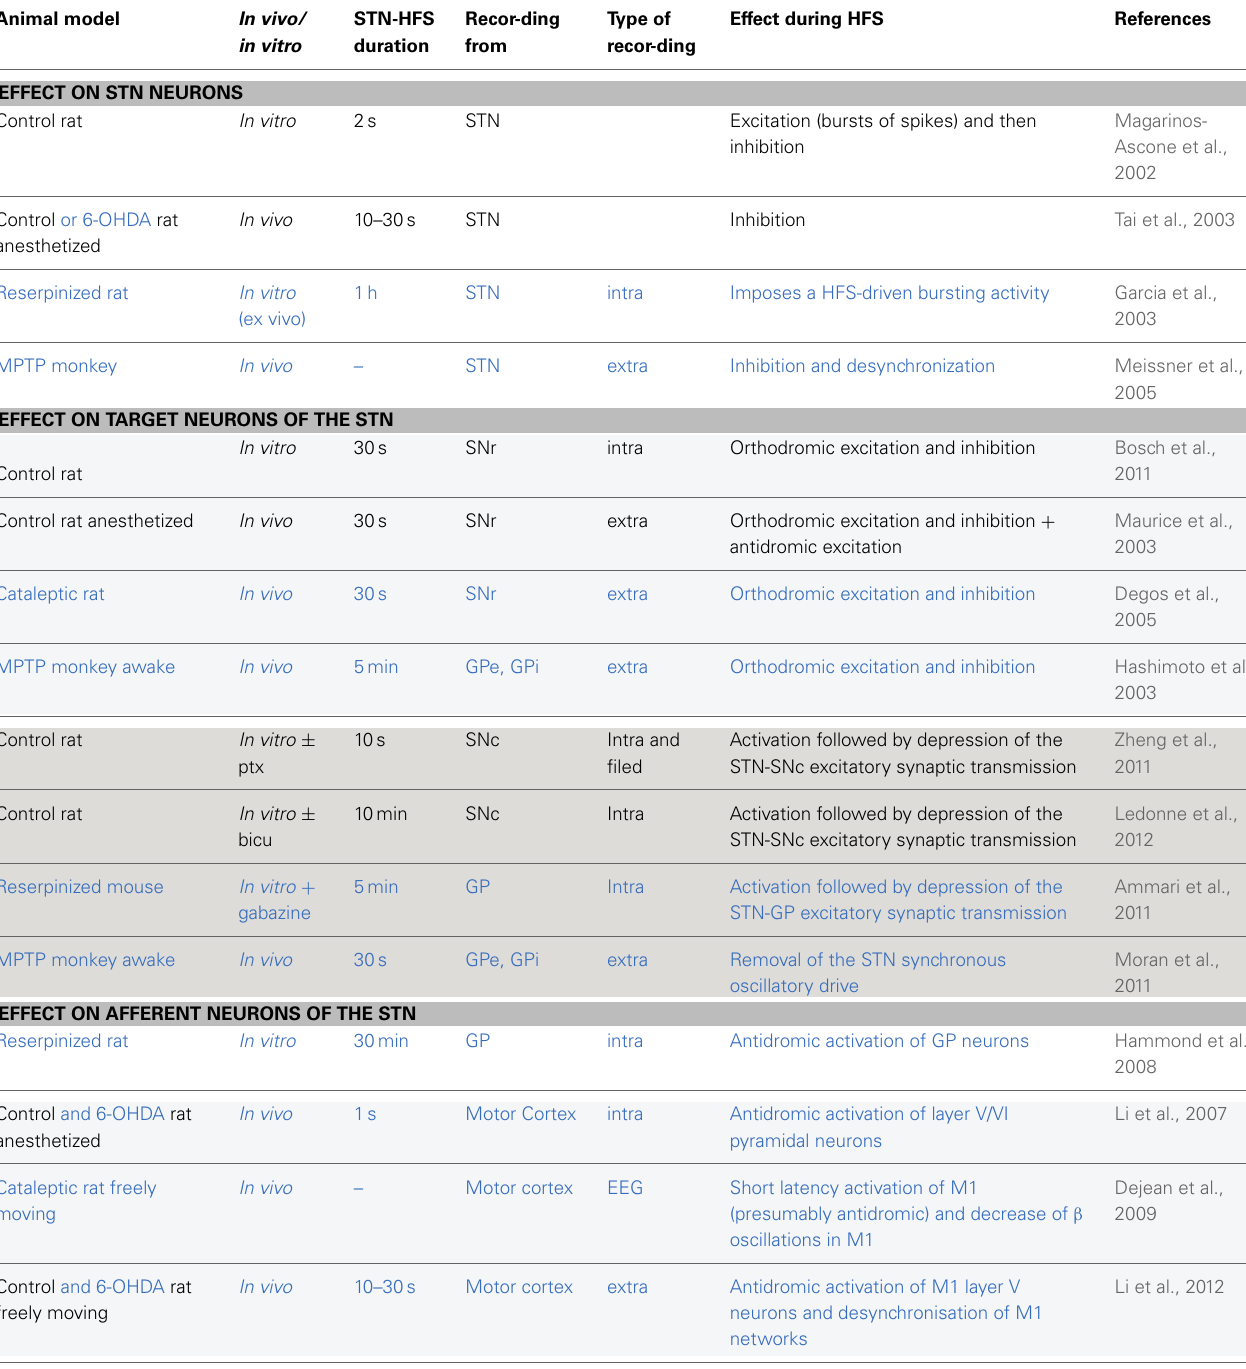
Table 1 | Electrophysiological effects recorded during STN-HFS in control animals (in black) or in animal models of Parkinson’s disease (in